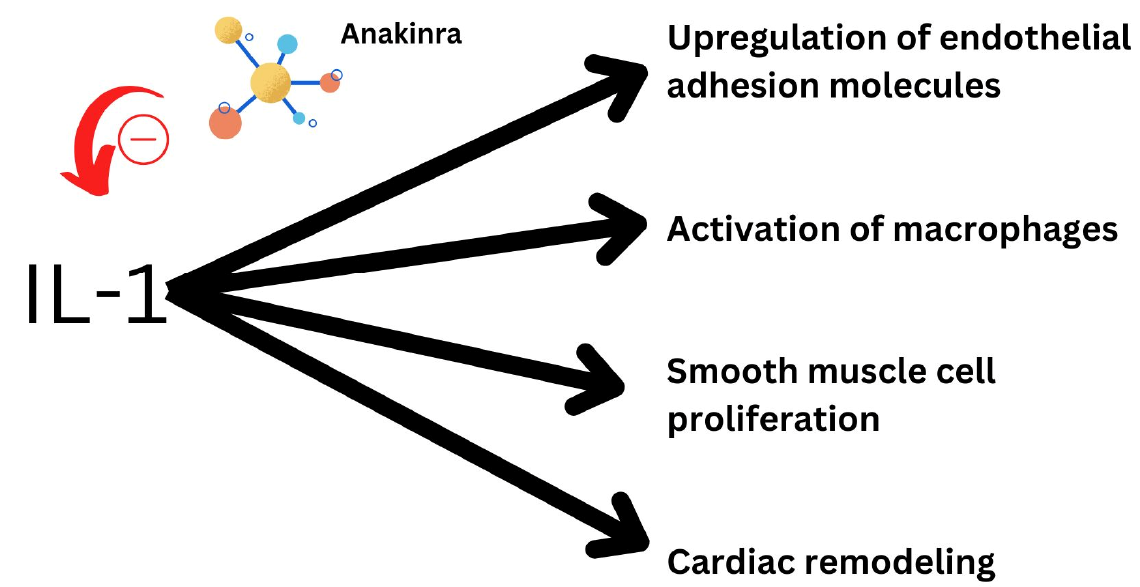
Figure 1. Effect of anakinra and its possible inhibitory effect on IL-1’s functions.